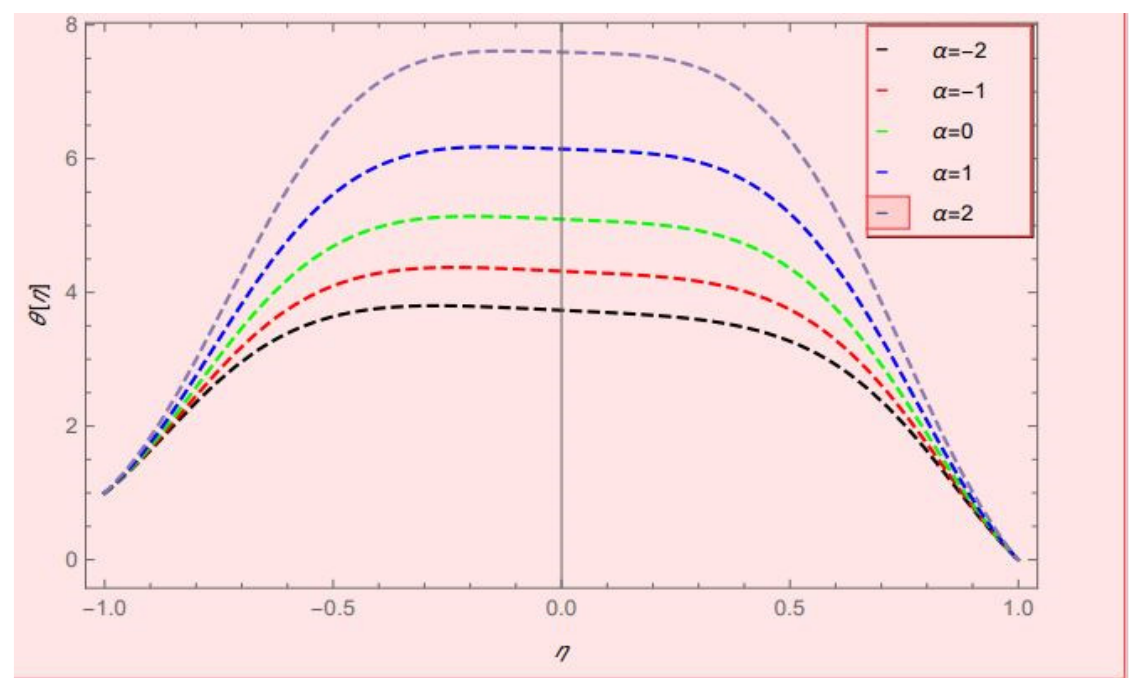
Figure 6. Temperature profile effect against the wall expansion and contraction ratio ( α ) for Re = 4, Pr = 0.1, Nt = Nb = 0.7, M = 13, β = 0.6, Br = 0.1, ϕ 1 = ϕ 2 = 0.02, h = 2, r = 1.5.